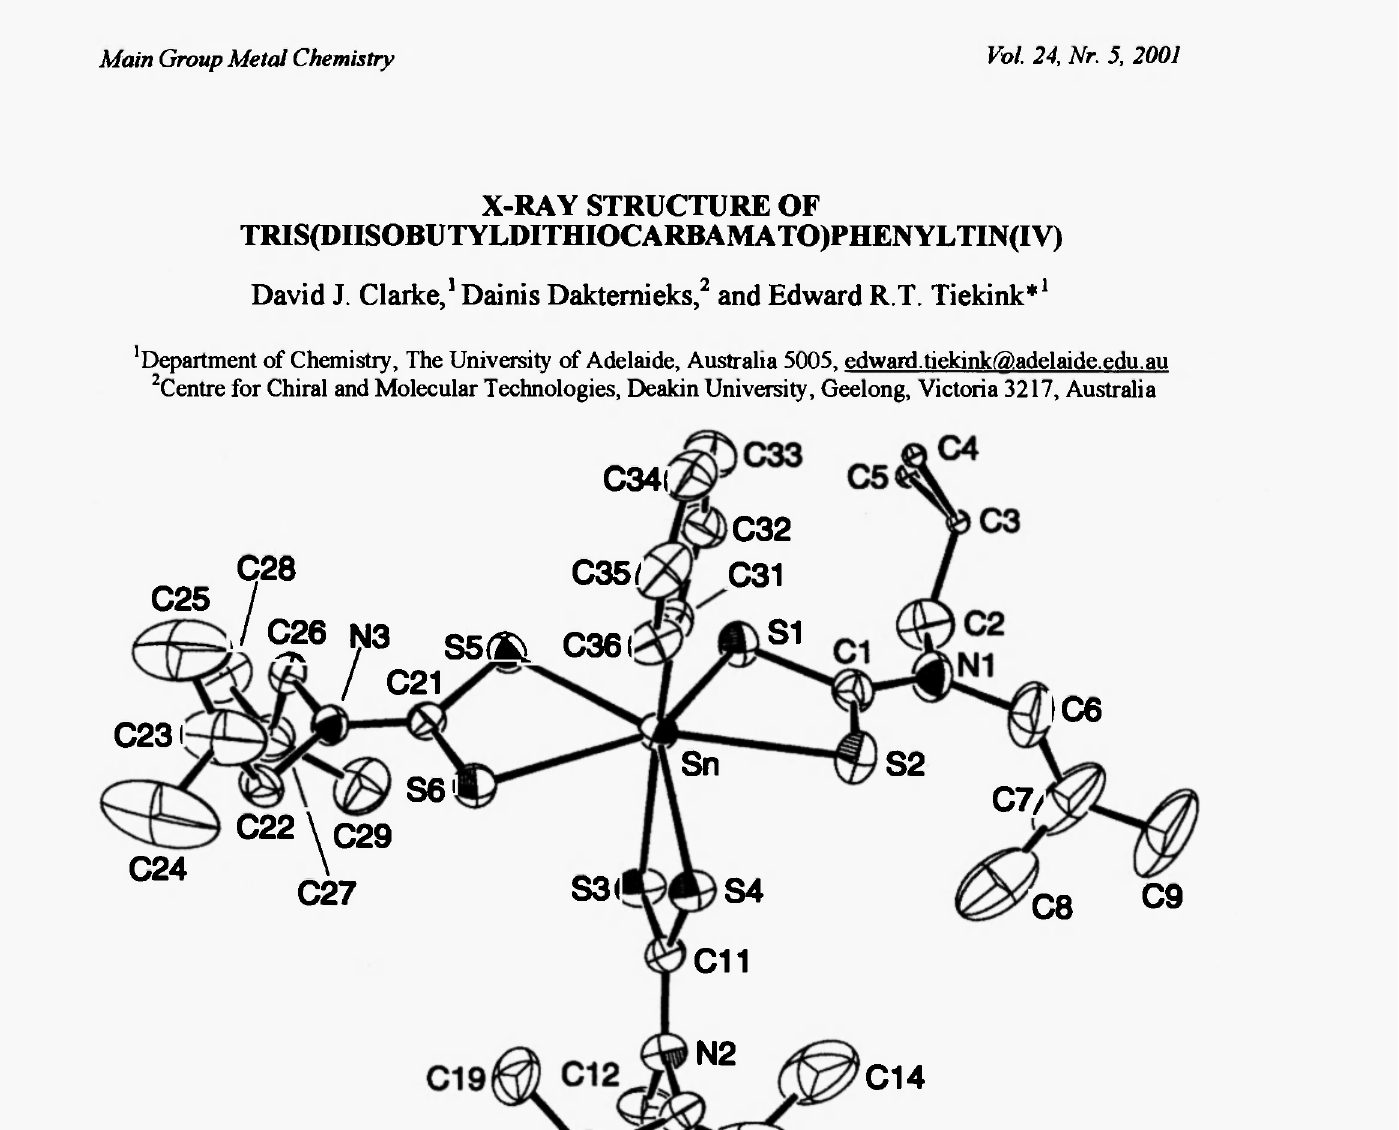
Figure 1. Molecular structure (50% displacement ellipsoids) of [PhSn^CNTh^]. Selected bond distances and angles: Sn-Sl 2.615(2), Sn-S2 2.709(1), Sn-S3 2.491(1), Sn-S4 2.729(1), Sn-S5 2.642(1), Sn-S6 2.774(2), Sn-C31 2.152(4), Sl-Cl 1.731(4), S2-C1 1.701(5), S3-C11 1.737(4), S4-C11 1.713(4), S5-C21 1.721(4), S6-C21 1.703(4),